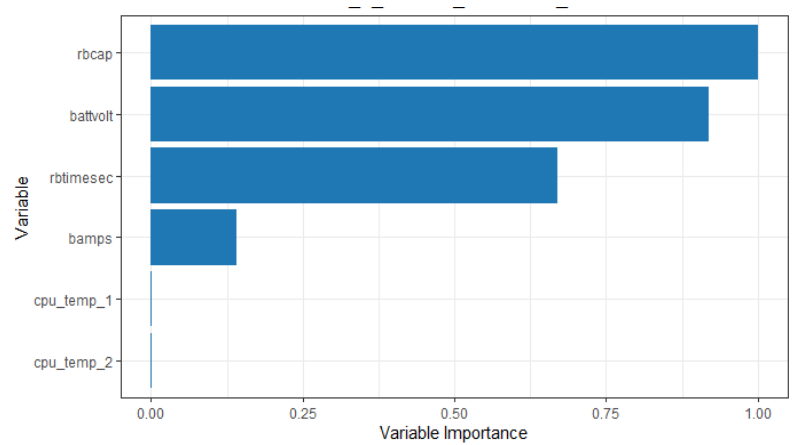
Figure 8. Variable importance for the GBM prediction